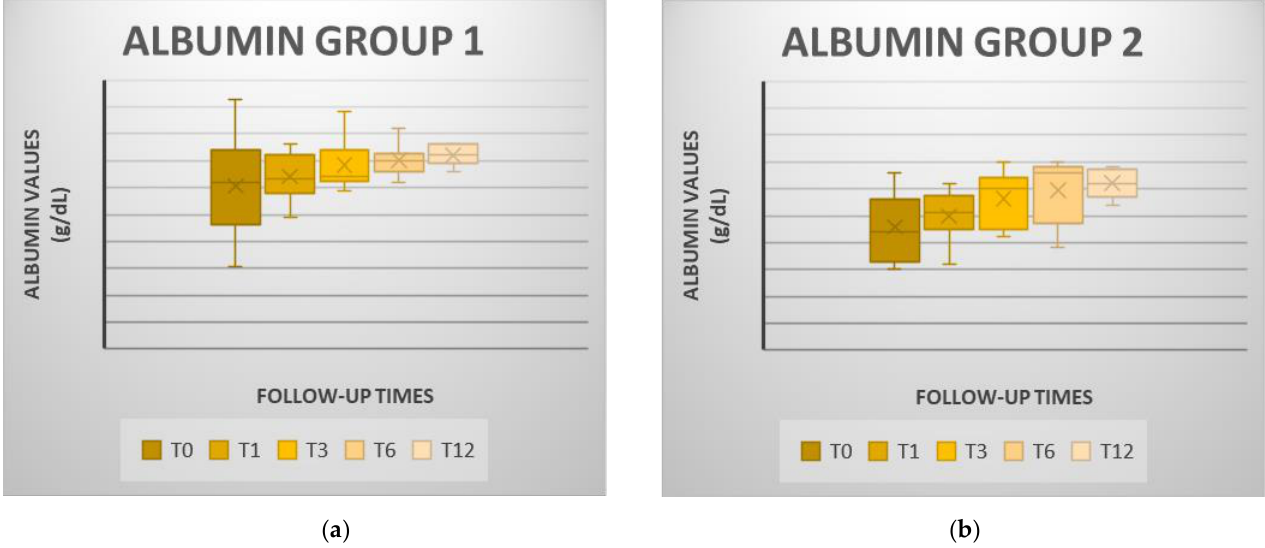
Figure 4. Albumin concentration values for the cell therapy group (MSC group; figure ( a )) and for the combined prednisone and stem cells group (P-MSC group; figure ( b )) at each review. In both groups, it is observed how the albumin value increases every checkpoint, presenting higher values in MSC group (group 1). Statistically significant differences in albumin concentration at each checkpoint were observed between both groups ( p < 0.05). Box and Whisker Diagram: the graphs show the median (line inside the box), 25th percentiles and 75 (box) and minimum and maximum values (whiskers).